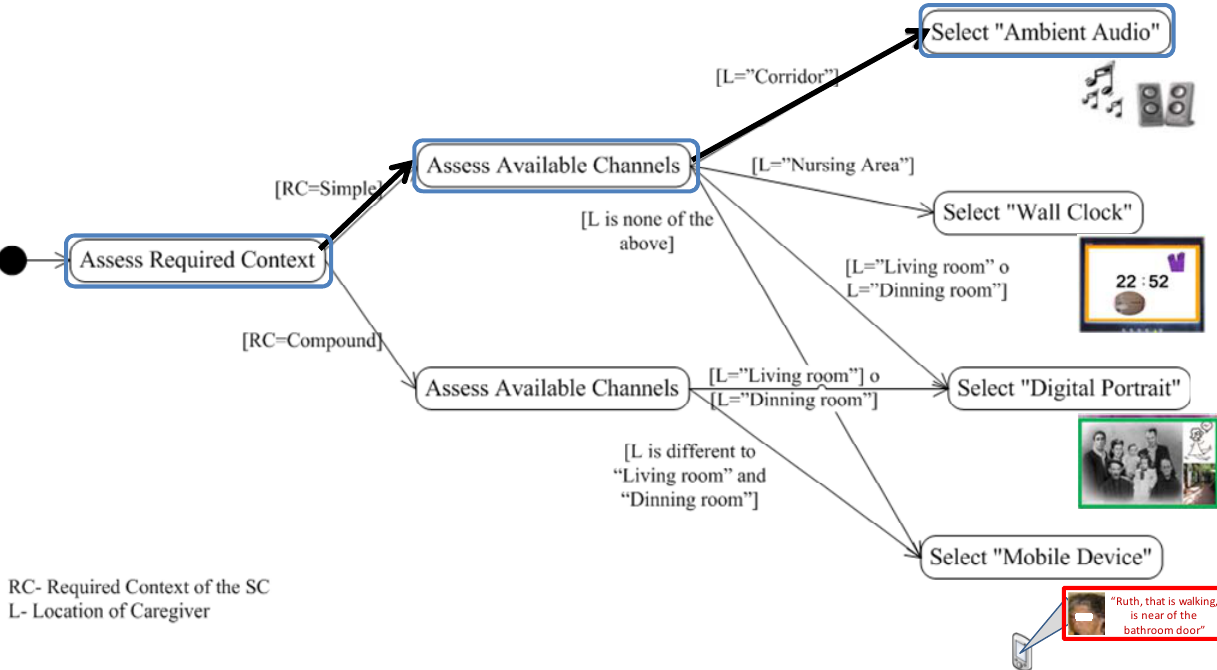
Figure 14. Decision tree to select the notification